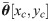
Example of a 9 × 9 interaction map of a V1 area centered on neurons strongly responding to a central preferred orientation of 30°.(A) Without feedback. (B) With a feedback strength equal to 1. These interaction maps are obtained when the SDPC is trained on natural images. At each location identified by the coordinates (xc, yc) the angle is θ¯[xc,yc] (see Eq 11) and the color scale is |a¯[xc,yc]| (see Eq 12). The color scale being saturated toward both maximum and minimum activity, all the activities above 0.8 or below 0.3 have the same color, respectively dark or white.